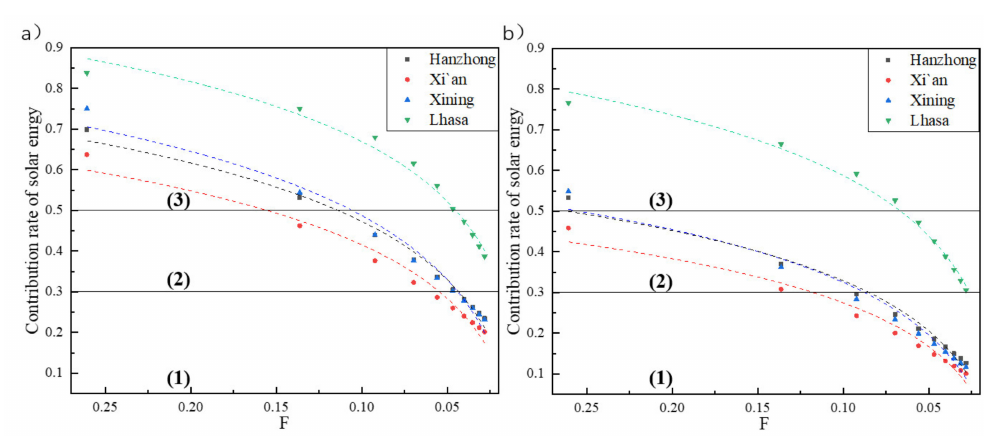
Figure 4. When F is the independent variable, in the four regions, the solar guarantee rate of office buildings and three-star hotels is shown in graph ( a ) and graph ( b